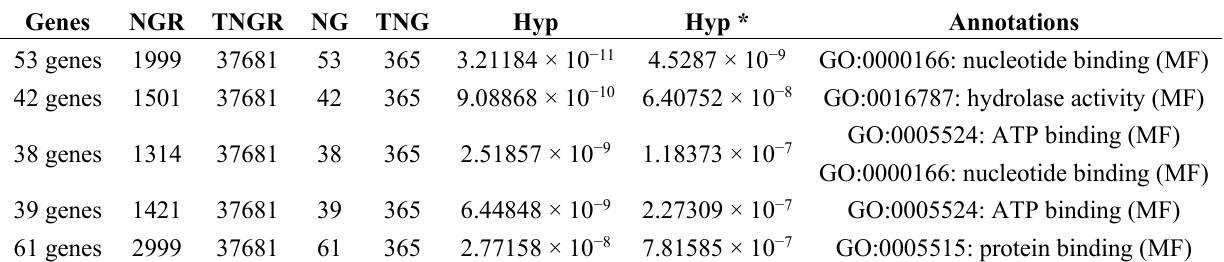
Chemokine signaling 4